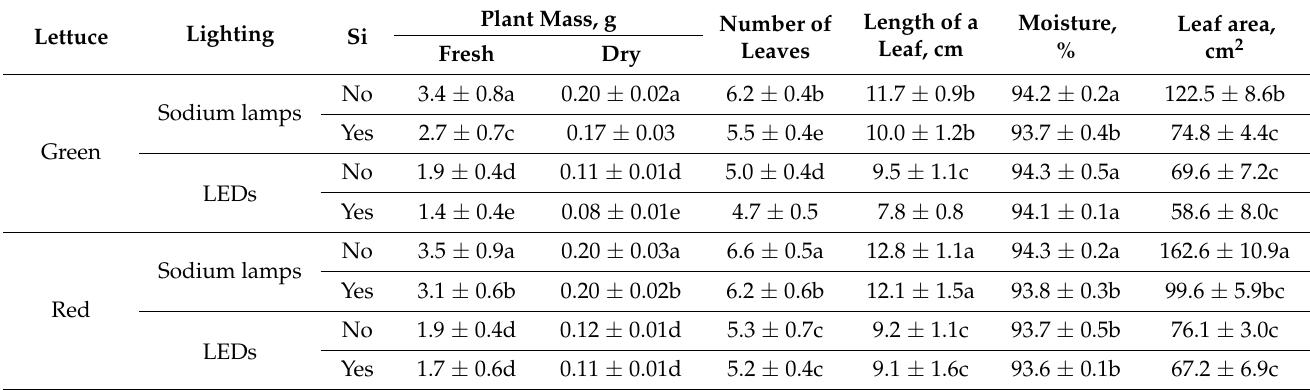
Table 1. Averaged biometric parameters of the aerial part of green and red lettuce ( Lactuca sativa L.) under conditions of a regulated agroecosystem on the 15th day of cultivation. Values represent mean ± SE ( n = 12). The different letters indicate significant differences among treatments mean non-significant differences among treatments according to Duncan’s test ( p ≤